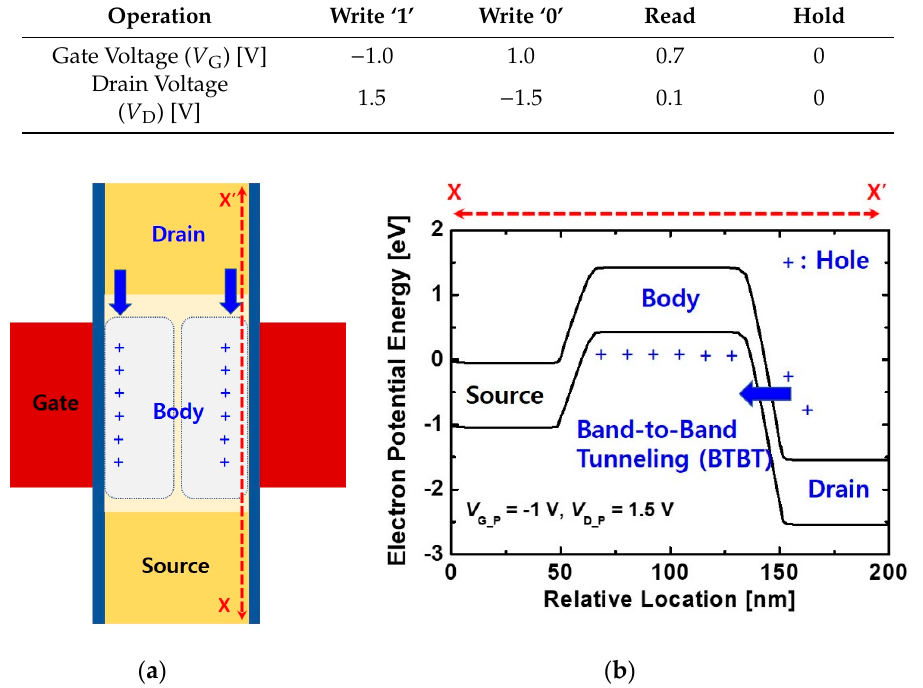
Figure 4. ( a ) A schematic diagram and ( b ) the energy band diagram for the write ‘1’ operation. V G_P and V D_P are − 1.0 V and 1.5 V, respectively. Table 1. Bias conditions for memory operations.